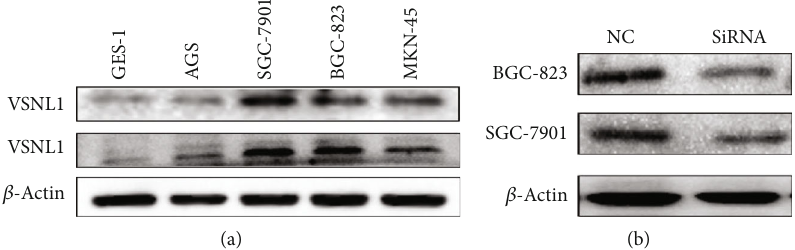
Figure 2: VSNL1 expression in GC cell lines. We repeated each experiment three times. (a) VSNL1 was highly expressed especially in SGC- 7901 and BGC-823. (b) The expression of VSNL1 was signi fi cantly downregulated after transfection.